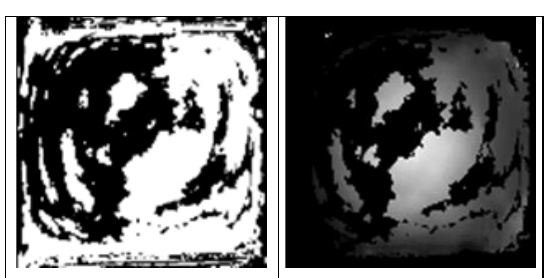
Figure 14. Result of segmentation (left) and result of dense matching (right). Brighter pixels indicate larger disparities.